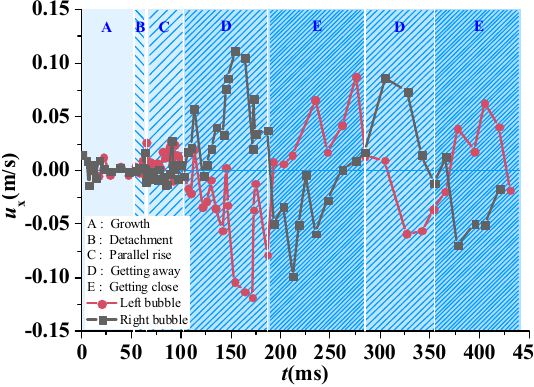
Figure 8. Lateral velocity versus time.